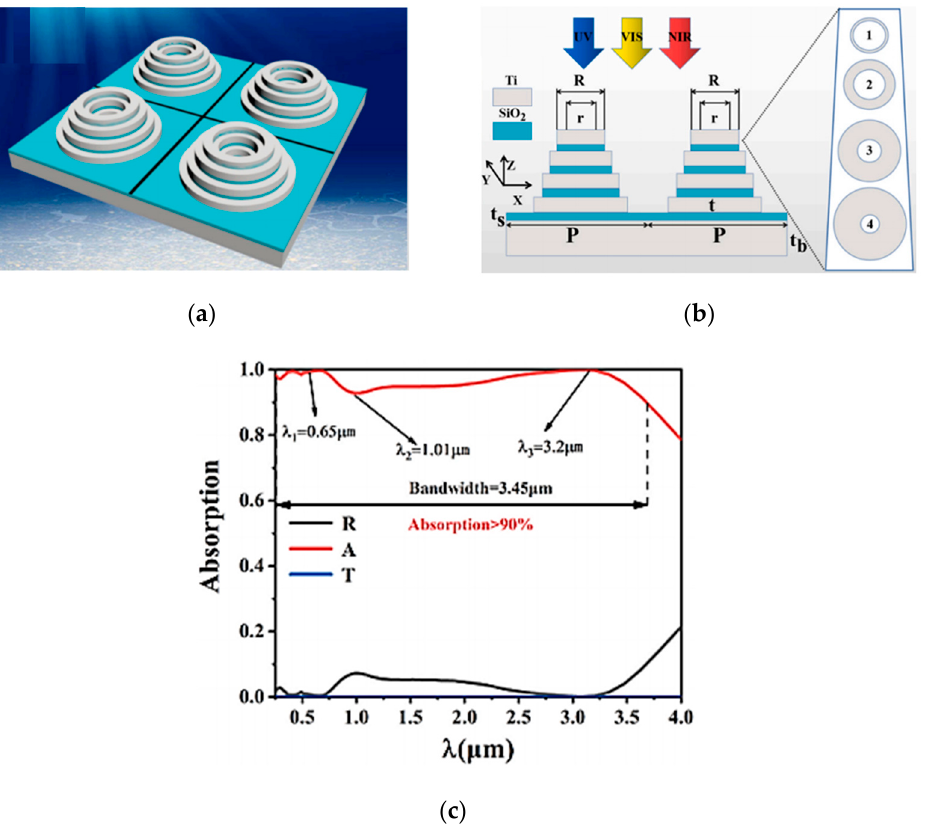
Figure 19. ( a ) Full spectrum absorber structure diagram; ( b ) full spectrum absorber plan; ( c ) full spectrum absorption spectrum, reflection spectrum, and transmission spectrum [56].